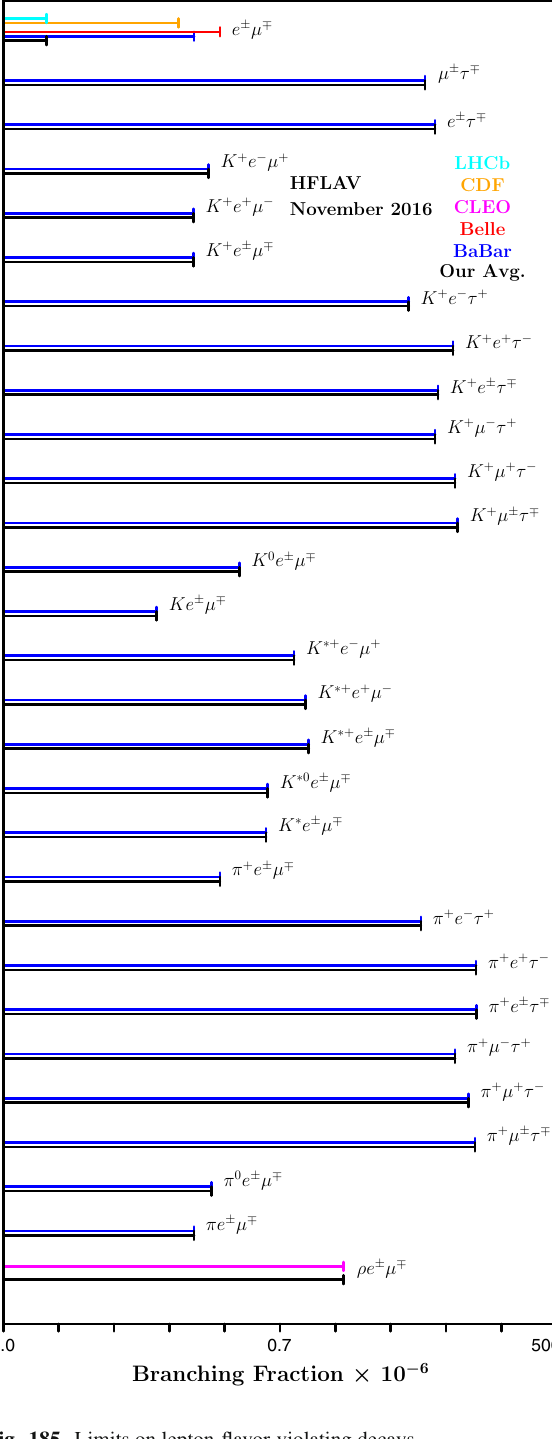
Fig. 185 Limits on lepton-flavor-violating decays